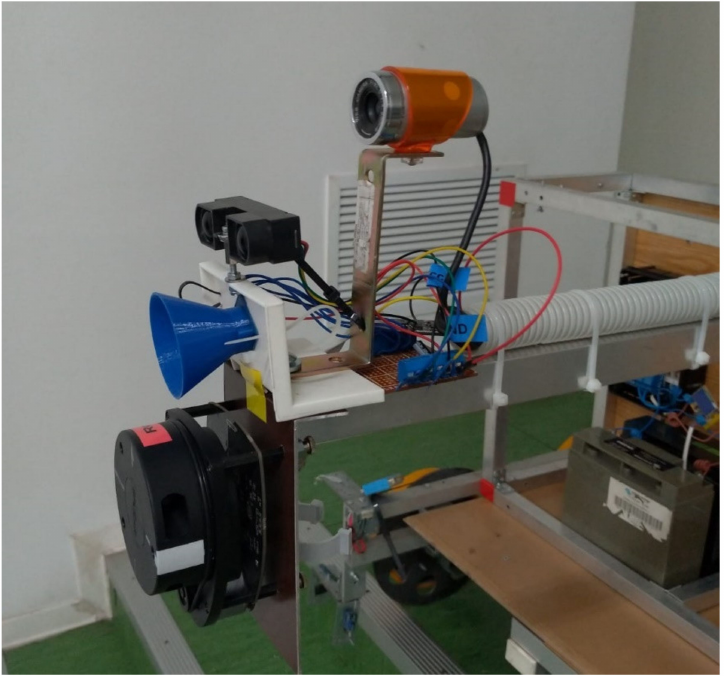
Figure 5. Detail with lateral view: web camera above, obstacle and fire/smoke detection